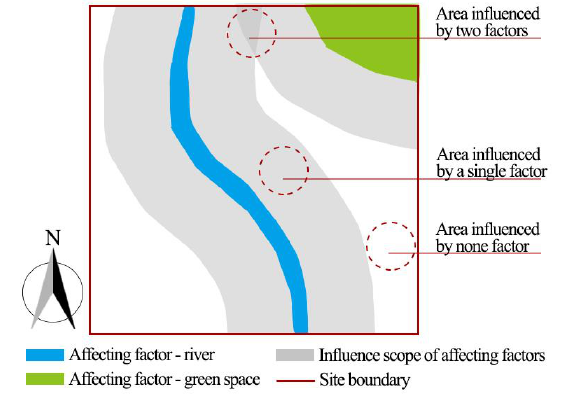
Figure 2. Affecting factors and their influence